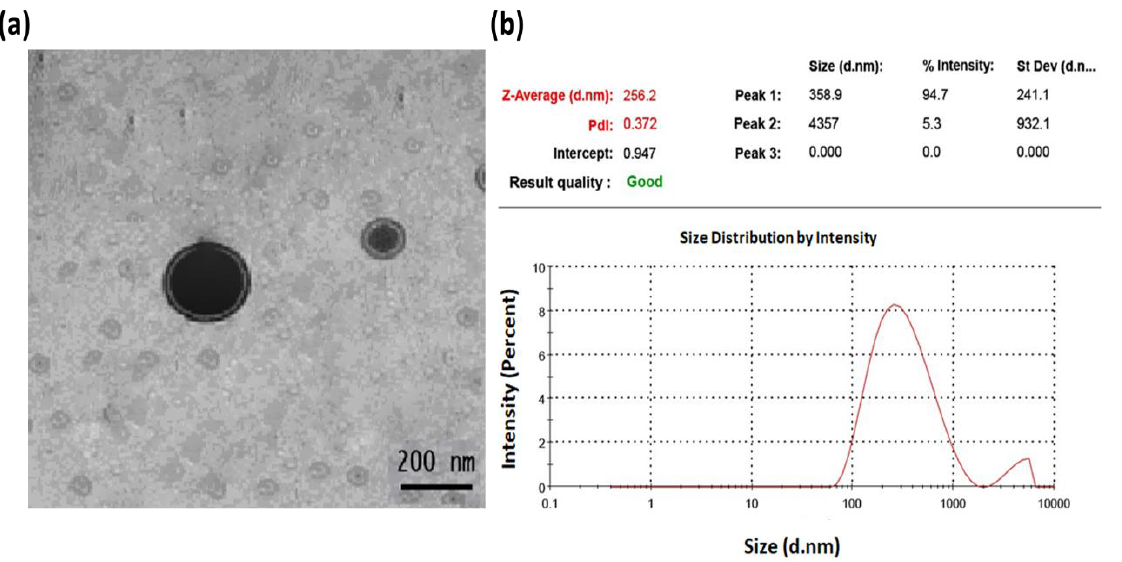
Figure 4. Transmission electron micrograph of optimized erythromycin transethosomes formulation ( a ) and vesicle size distribution curve ( b ).